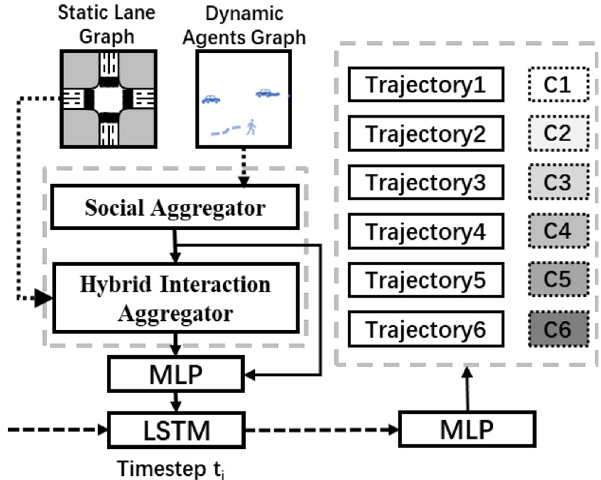
Figure 2 Model overview